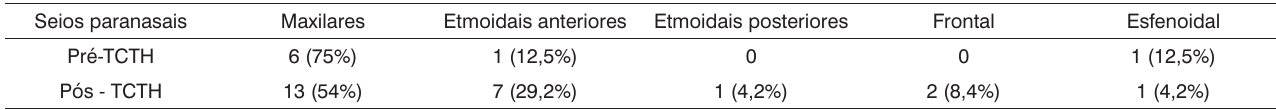
Tabela 1. Número de seios paranasais acometidos conforme tomografia computadorizada anterior e após transplante de células-tronco he- matopoiéticas.